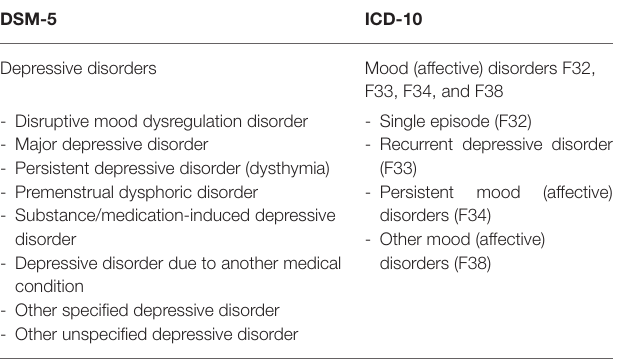
TABLE 1 | Depressive disorders according to the DSM-5 and the ICD-10. DSM-5